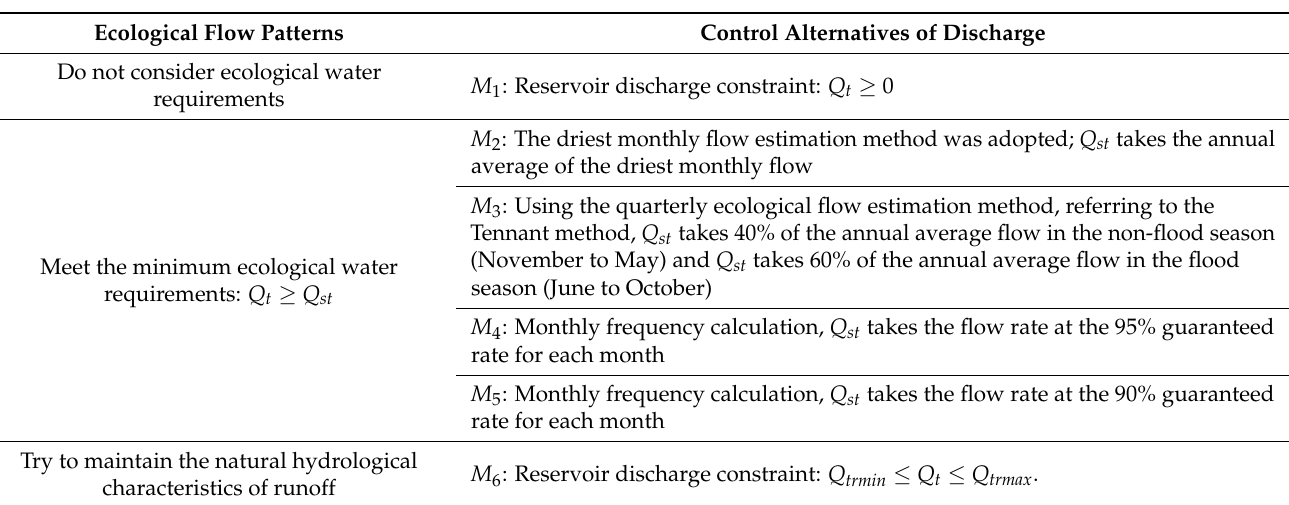
Table 1. Eco-friendly reservoir control